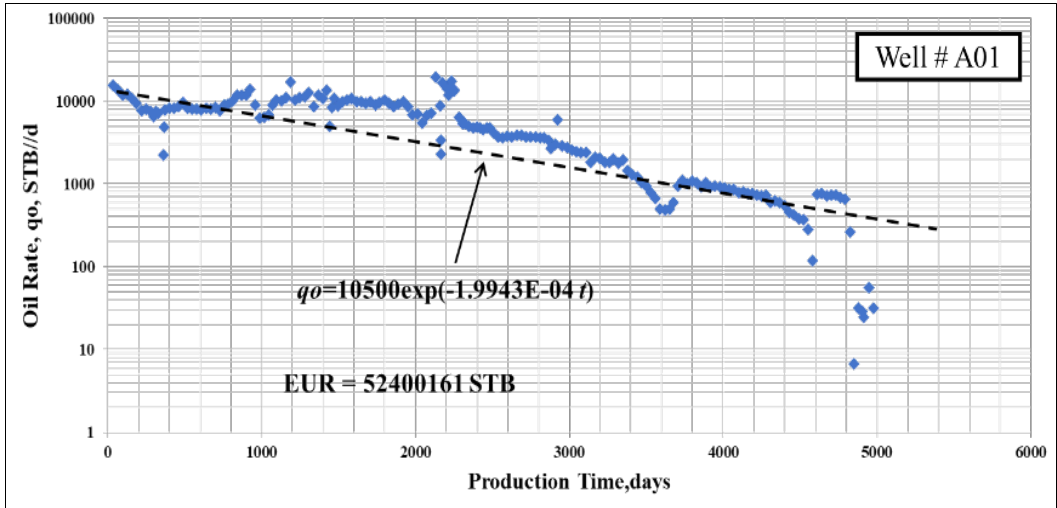
Figure 2. Oil production rate versus production time for well A01